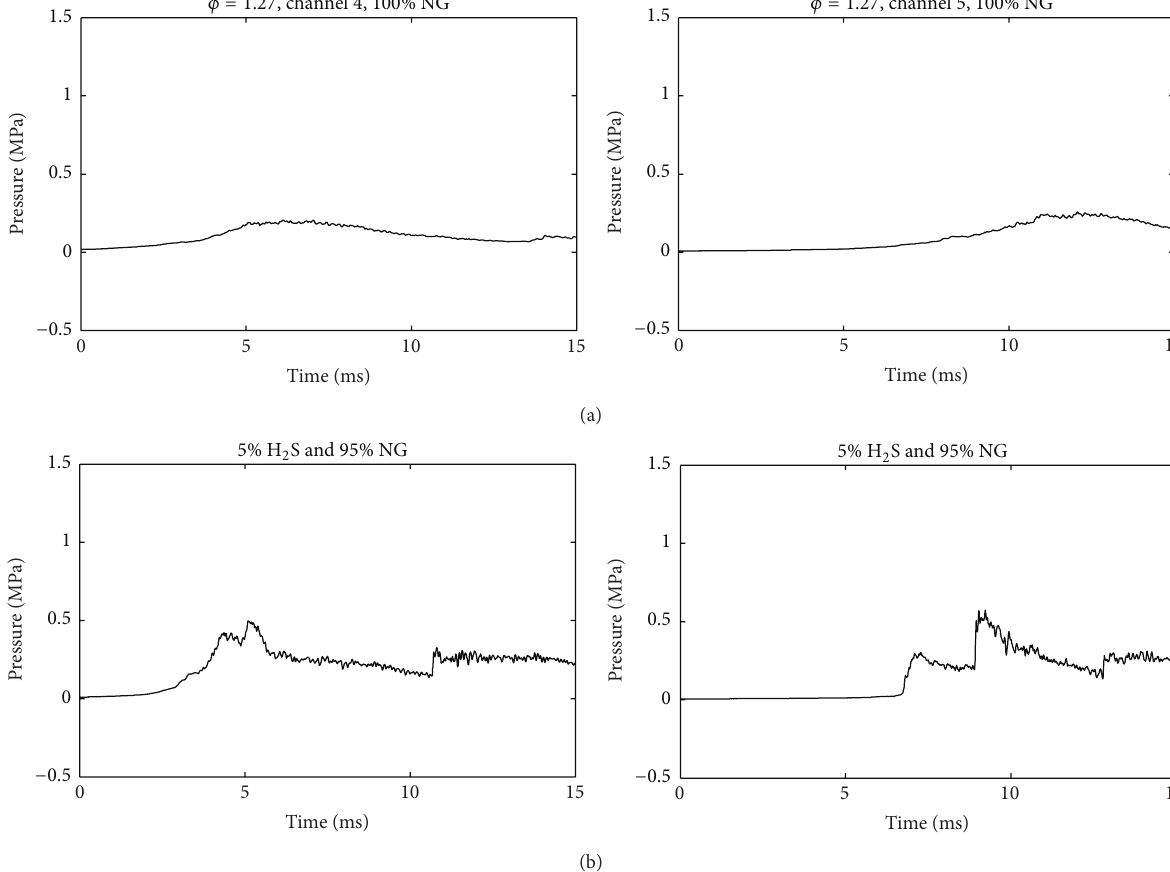
Figure 16: Comparison of explosion pressures for 𝜙 = 1.27 in the obstructed section (channel 4) and the smooth section (channel 5). (a) 100% NG and (b) NG with 5% H 2